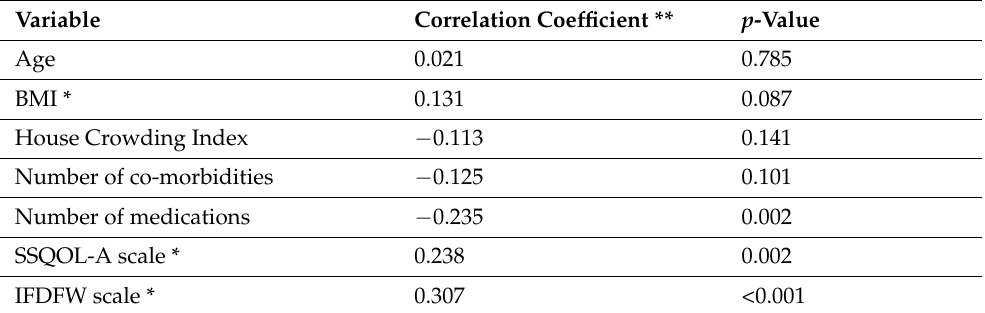
Table 6. Bivariate analysis of sociodemographic, socioeconomic, and clinical characteristics of the patients, taking the LMAS-14 as the dependent